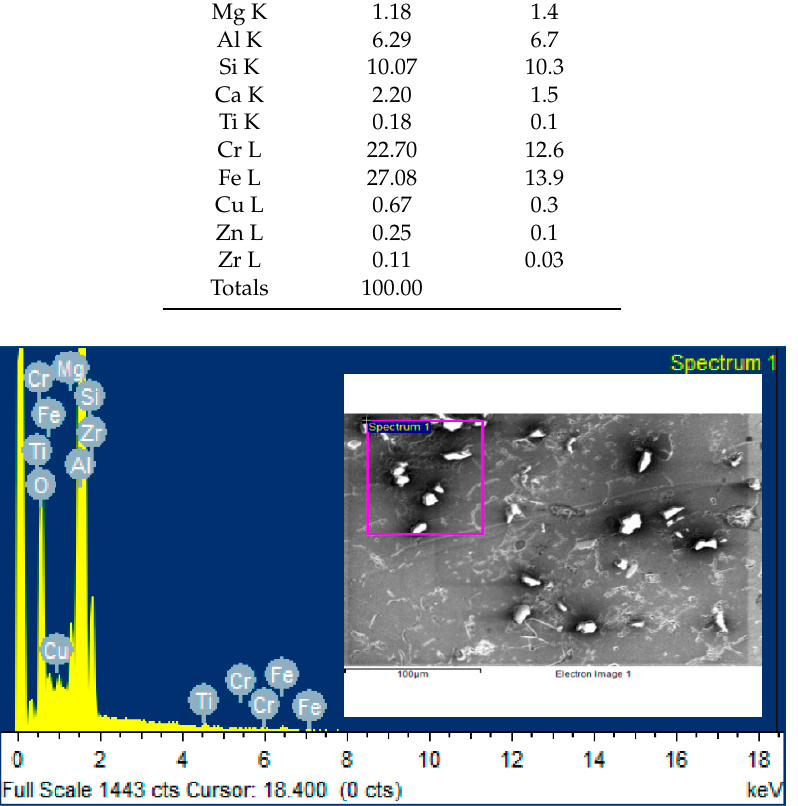
Figure 2. Elements of AA6061/ZrO 2.